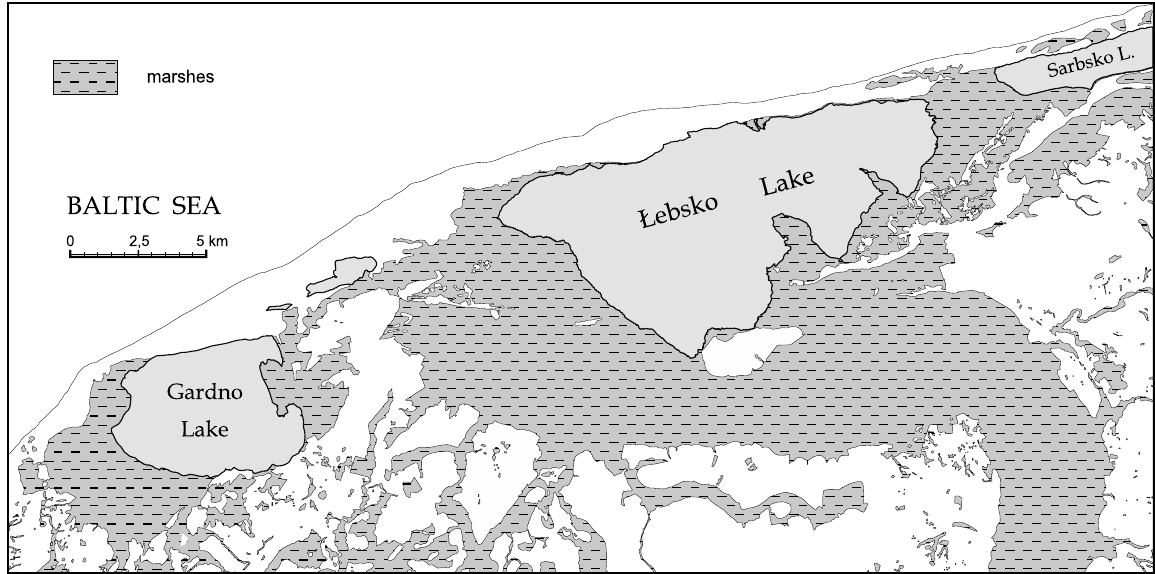
Fig. 3. Extent of wetlands in Gardno-Łeba Lowland in the early 19th